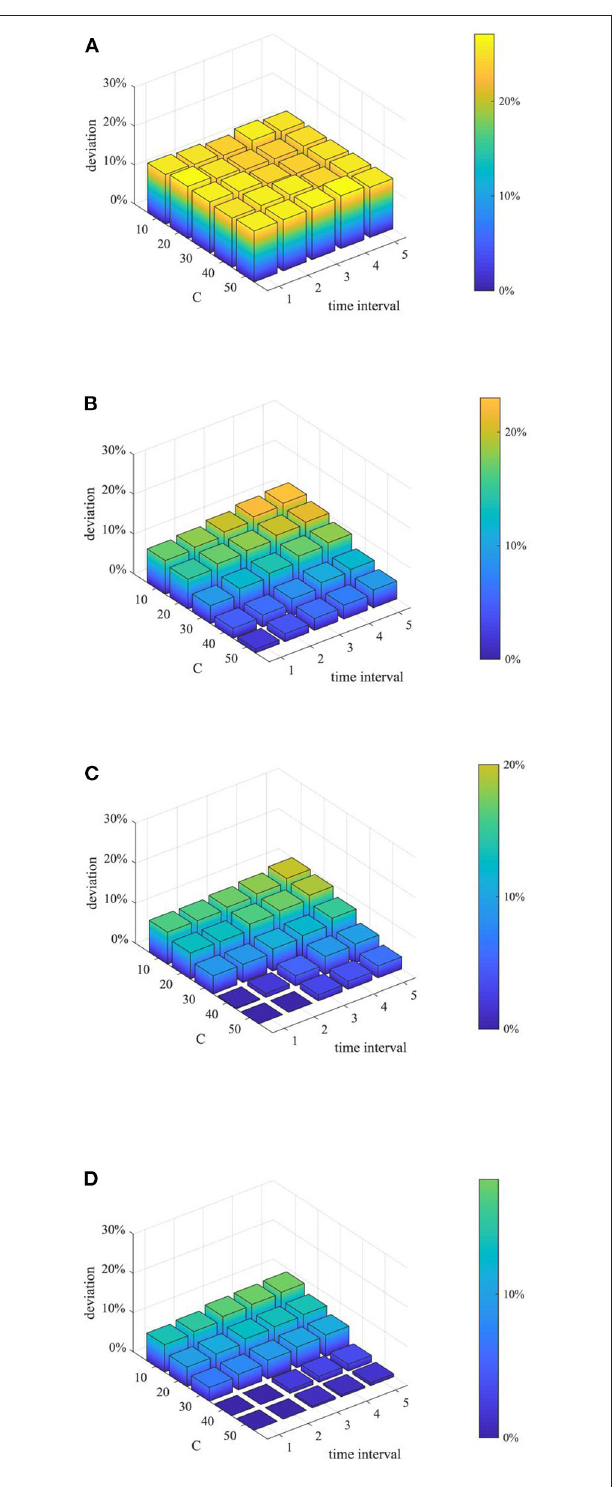
FIGURE 17 | Entire network information content deviation based on different combination. (A) t = 10. (B) t = 20. (C) t = 30. (D) t = 40.